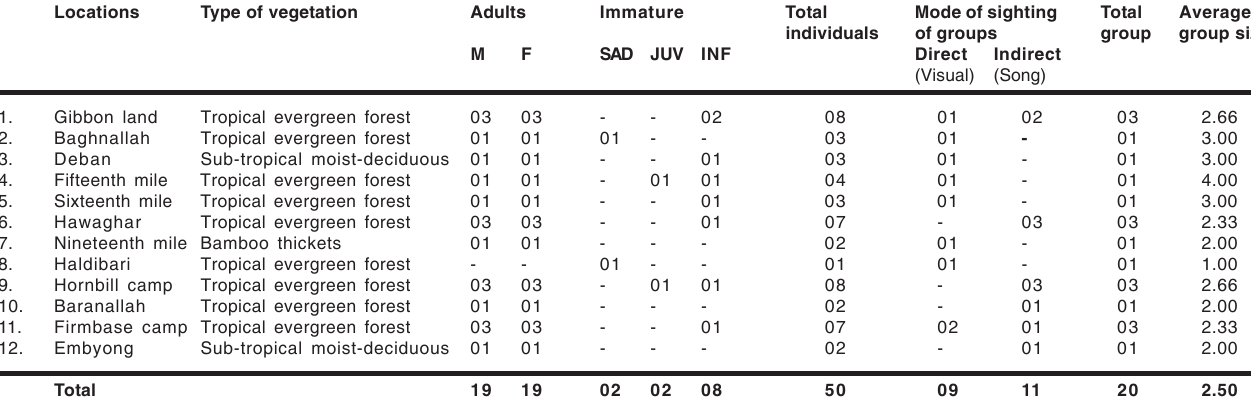
M - Male; F - Female; SAD - Sub-adult; JUV - Juvenile; INF - Infants